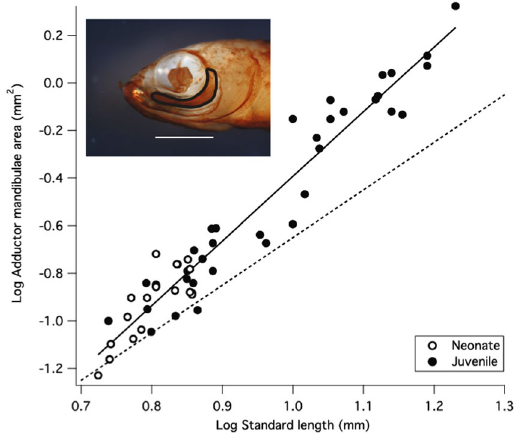
Figure 8. Positive allometric scaling of surface area of the adductor mandibulae relative to body length. Inset shows adductor mandibulae muscle area outlined in black (scale bar = 1 mm). If area of the adductor mandibulae increased isometrically, the points would fall along the dotted line with a slope of 2, which indicates isometry of surface area relative to standard length. Positive allometry indicates that growth of the adductor mandibulae outpaces growth of the